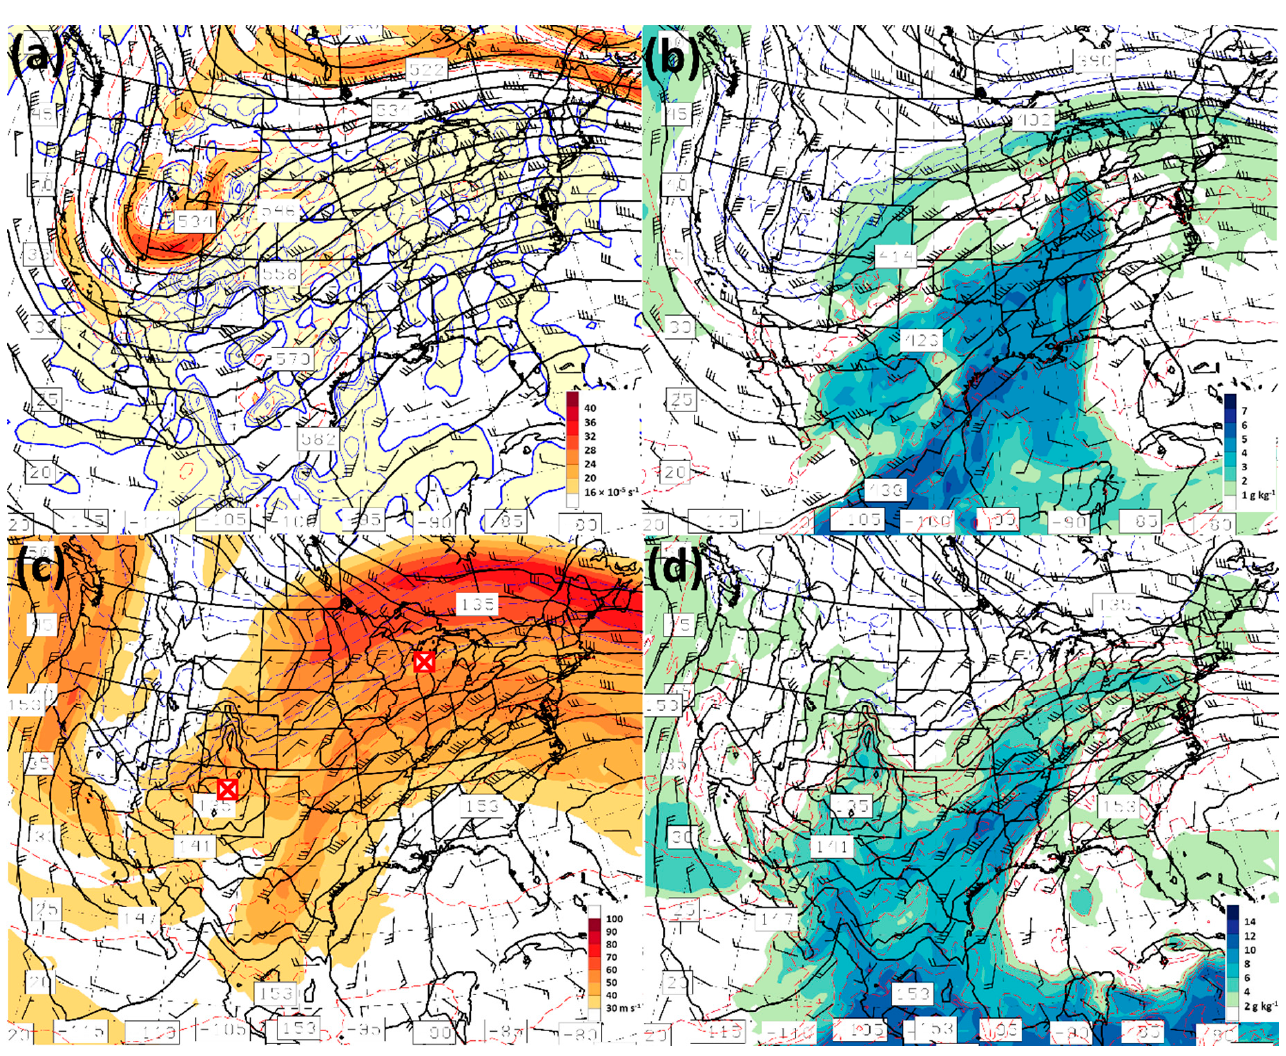
Figure 3. GFS − analyzed fields valid at 0000 UTC 4 February 2020 of: ( a ) 500 hPa level geopotential height (dam, solid black contours), absolute vorticity × 10 − 5 (s − 1 , shading and red dashed contours), and wind vectors (kt) and 700 hPa level rising motion × 10 − 3 (hPa s − 1 , vanilla shading and blue solid contours); ( b ) 600 hPa level geopotential height (dam, solid black contours), mixing ratio (g kg − 1 , shading), equivalent potential temperature (K, final blue (first red) dashed contour value is 304 K (310 K)), and wind vectors (kt); ( c ) 850 hPa level geopotential height (dam, solid black contours) and wind vectors (kt) and 1000-500 hPa layer thickness (dam, final blue (first red) dashed contour value is 540 dam (546 dam)), and 300 hPa level wind speed (m s − 1 , shading); and ( d ) 850 hPa level geopotential height (dam, solid black contours), mixing ratio (g kg − 1 , shading), wind vectors (kt), and equivalent potential temperature (K, final blue (first red) dashed contour value is 280 K (286 K)). Red cross-square symbols in panel ( c ) represent the locally dominant 850 hPa level cyclone center.